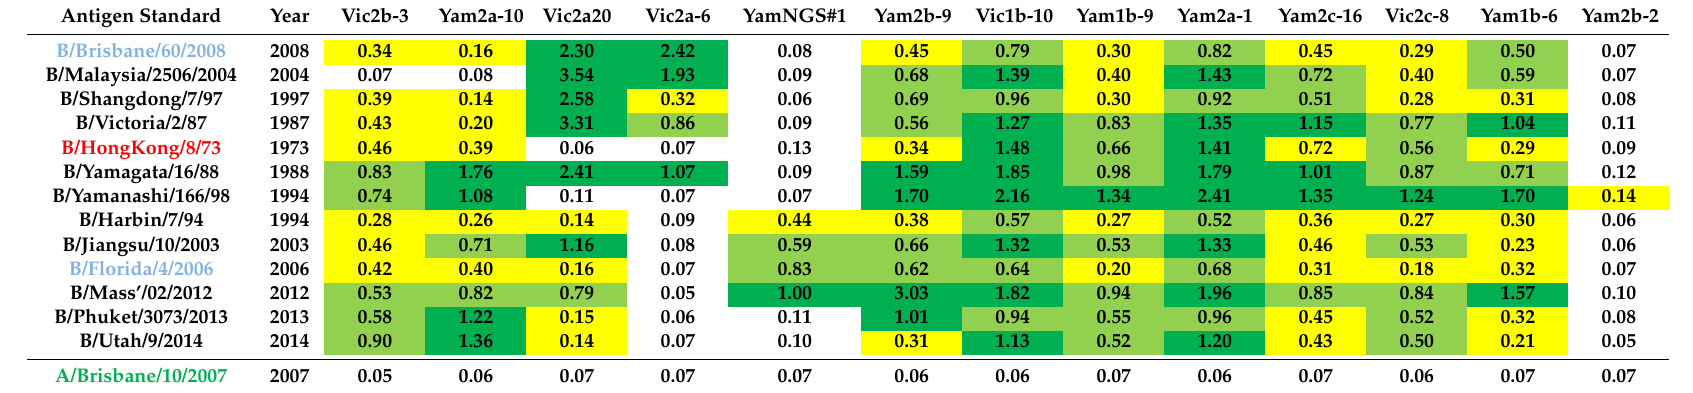
Table 2. Single domain antibody recognition of the whole virus antigen standards by